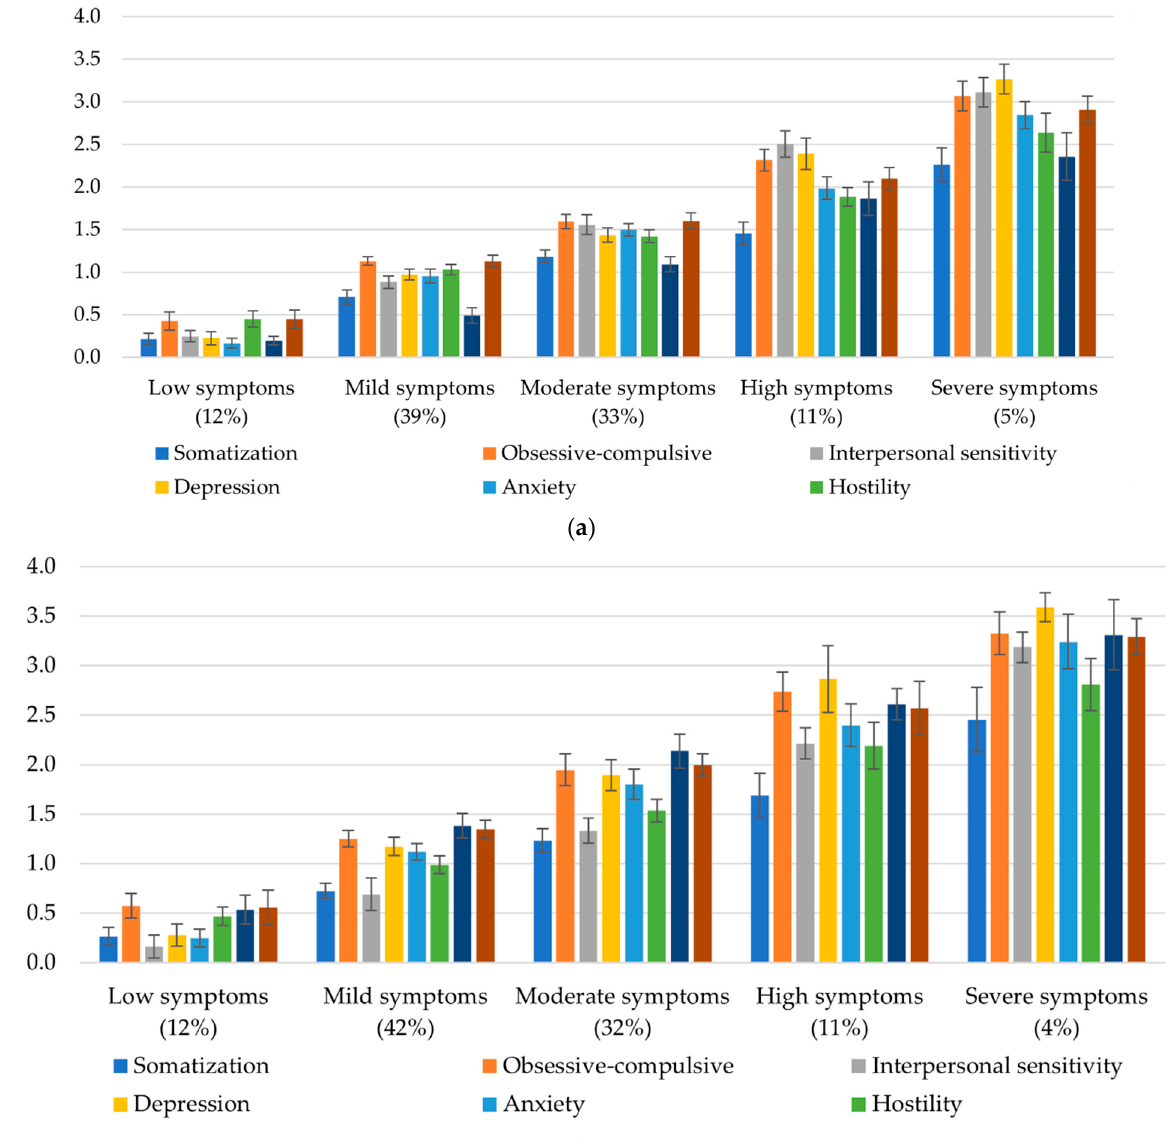
Figure 2. Subgroup means for pre- and post-COVID BSI subscales with 95% confidence intervals. Y -axis values represent mean scores for each subscale. ( a ) Subgroup means for pre-COVID BSI subscales; ( b ) subgroup means for post-COVID BSI subscales. BSI